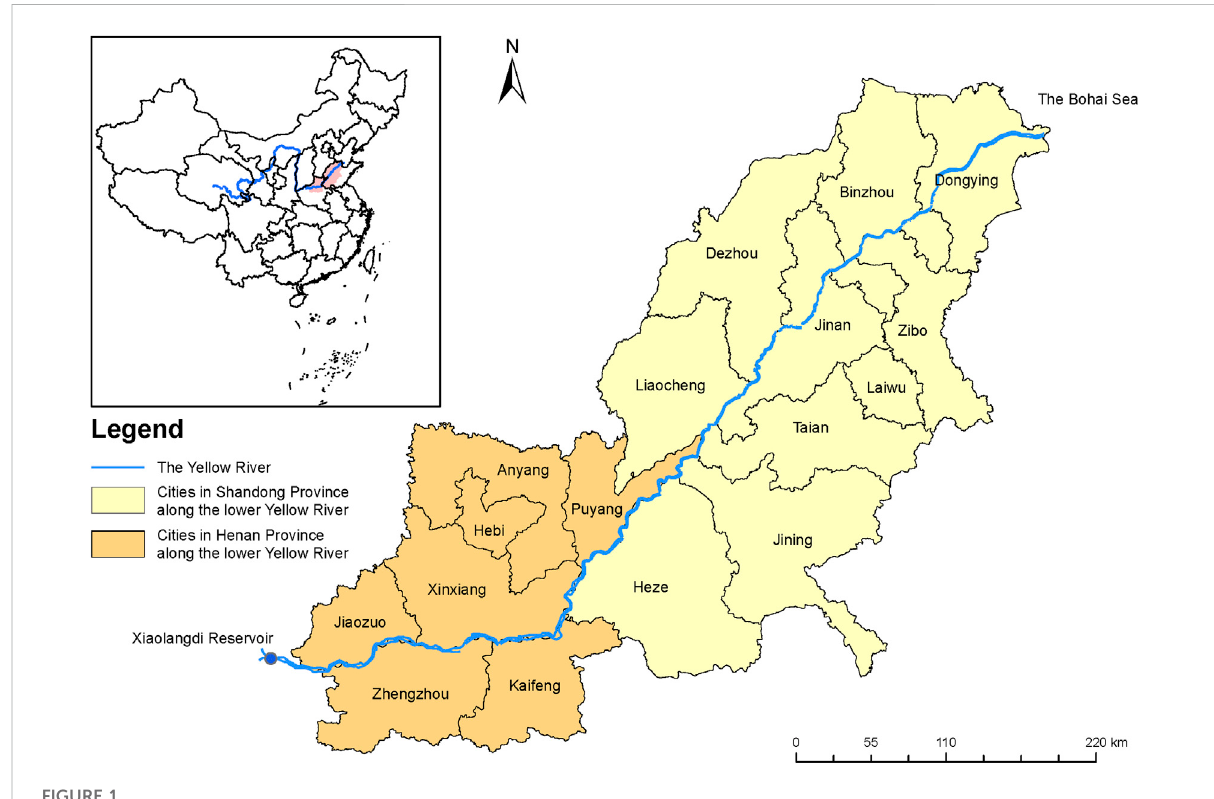
FIGURE 1 City group map along the lower Yellow River.